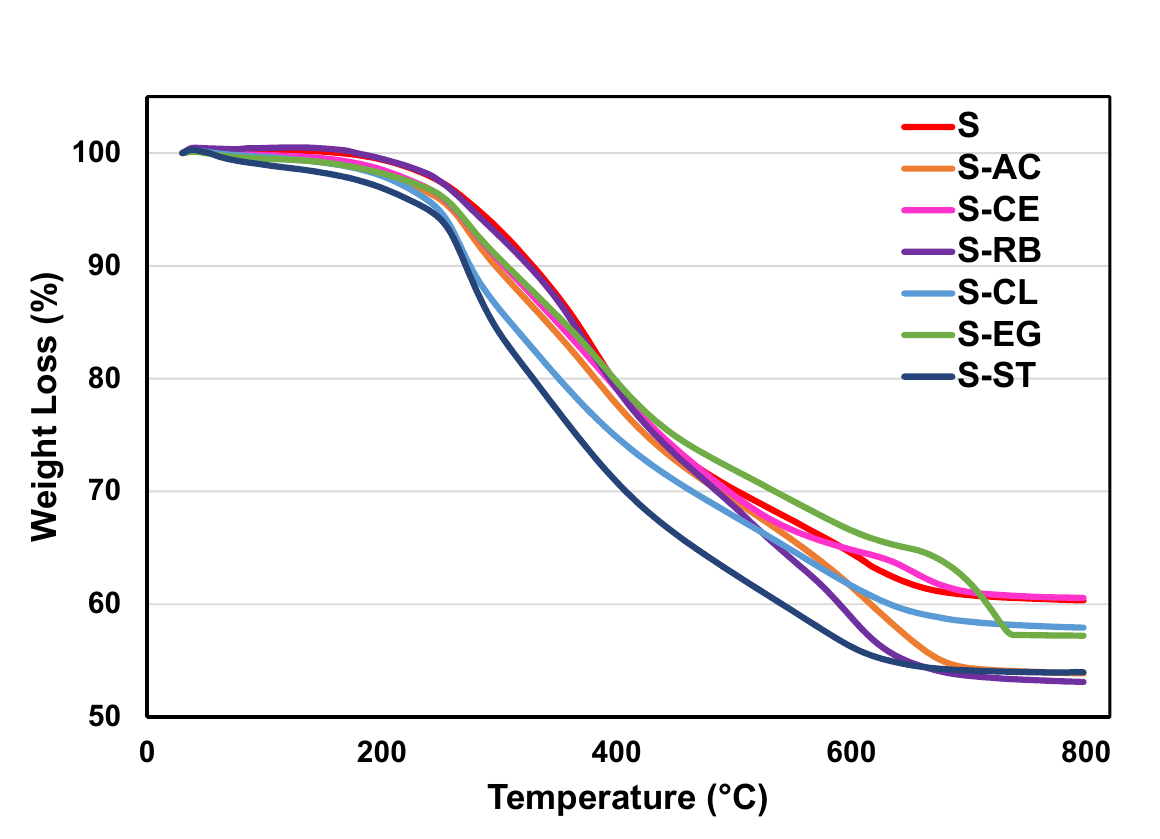
Figure 4. TGA plots of the S-coating matrices.